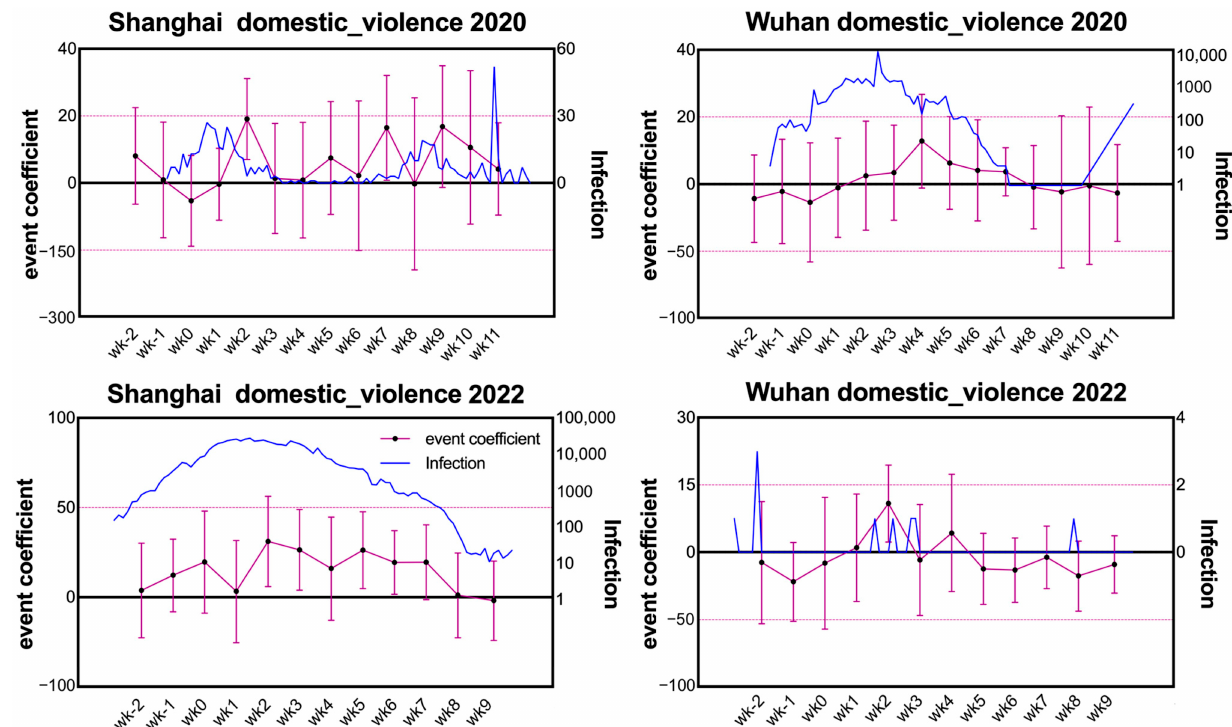
Figure 3. Trend of 𝛼 (cid:3038) /𝛽 (cid:3038) for domestic violence, Shanghai vs. Wuhan, 2019–2022. Figure 3. Trend of α k / β k for domestic violence, Shanghai vs. Wuhan,